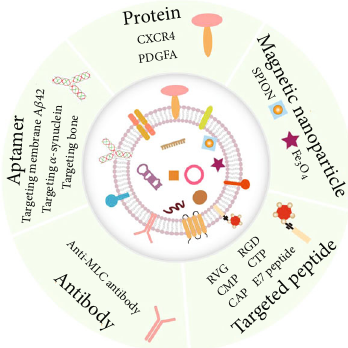
Figure 2: The strategies of engineering EVs to increase their targeting ability. The targeting modi fi cation mainly involves the utilization of targeted peptide (RVG, RGD, CMP, CTP, CAP, and E7 peptide), magnetic nanoparticles (SPION, Fe (CXCR4, PDGFA), aptamer (Targeting membrane A β 42, α - synuclein and bone), and antibody